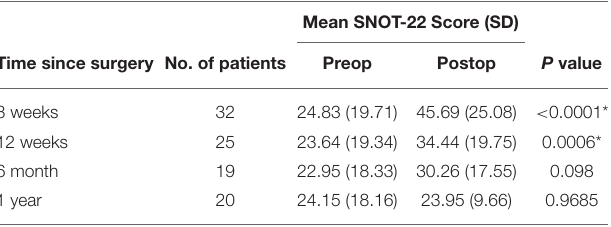
TABLE 3 | Overall postoperative SNOT-22 scores in patients who underwent endoscopic